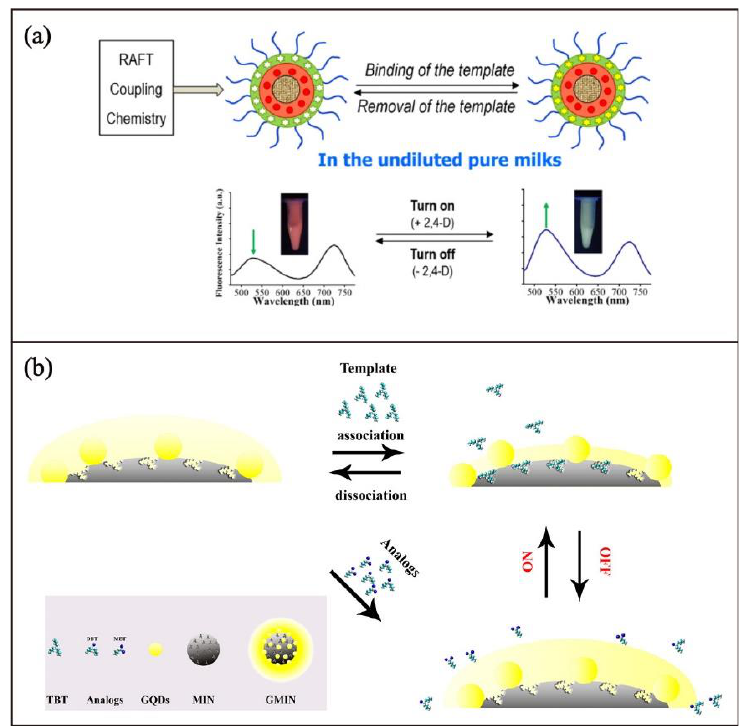
Figure 9. Schematic illustration for ( a ) the preparation of fluorescent MIP-coated CdTe QDs for 2,4-dichlorophenoxy acetic acid detection. Adapted with permission [112]. Copyright 2020, American Chemical Society. ( b ) Preparation and sensing principle of the graphene QDs-immobilized MIP nanocomposite for the detection of tributyltin. Adapted with permission [117]. Copyright 2019, American Chemical Society.